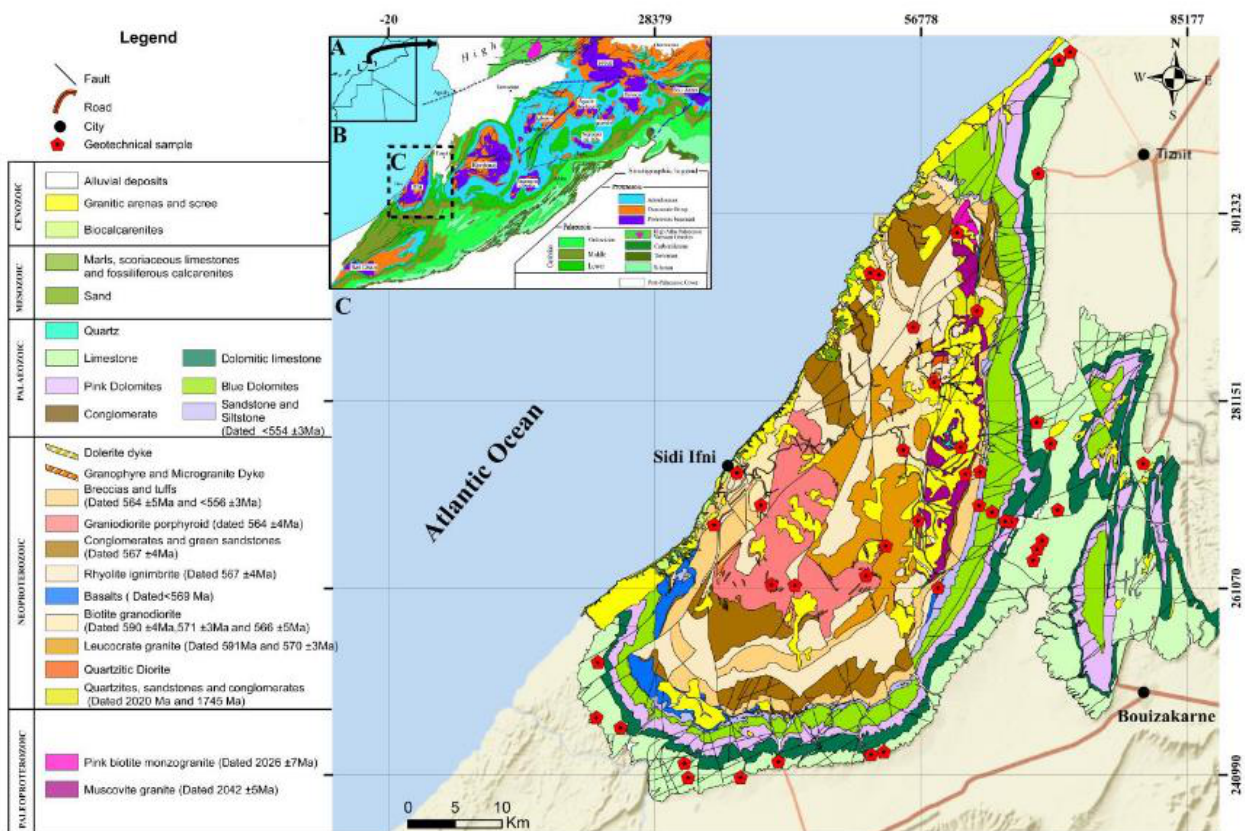
Figure 4. Simplified geological map of the Ifni inlier and Lakhssas plateau. Figure 4. ( A ) Geographical localisation of Morocco, ( B ) Emplacement of the Ifni inlier and Lakhssas plateau in the Moroccan geological map and ( C ) Simplified geological map of the Ifni inlier and Lakhssas plateau. Table 2. Geotechnical testing.